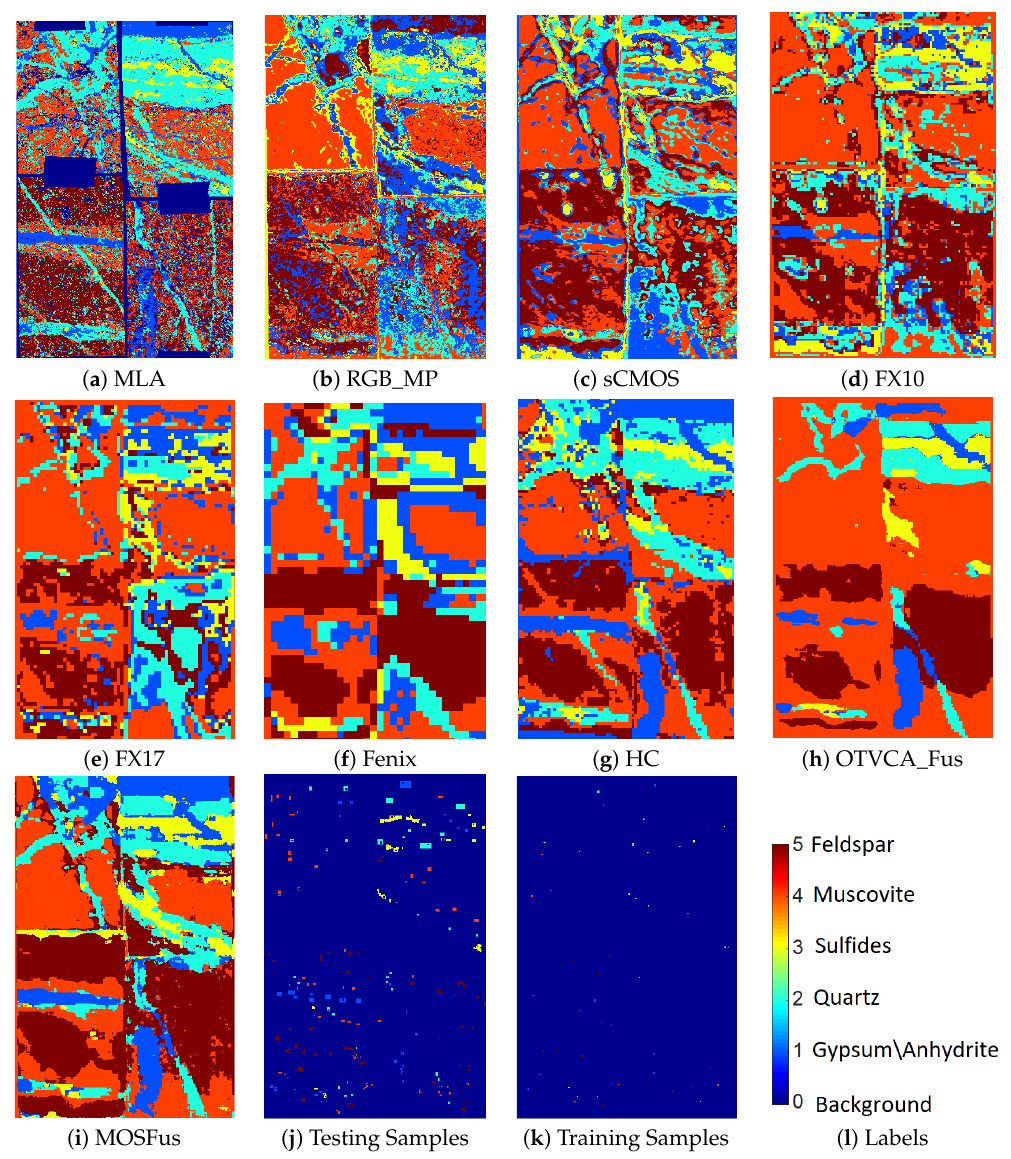
Figure 4. The classification maps of different fusion techniques and different sensors using SVM applied on the TS4